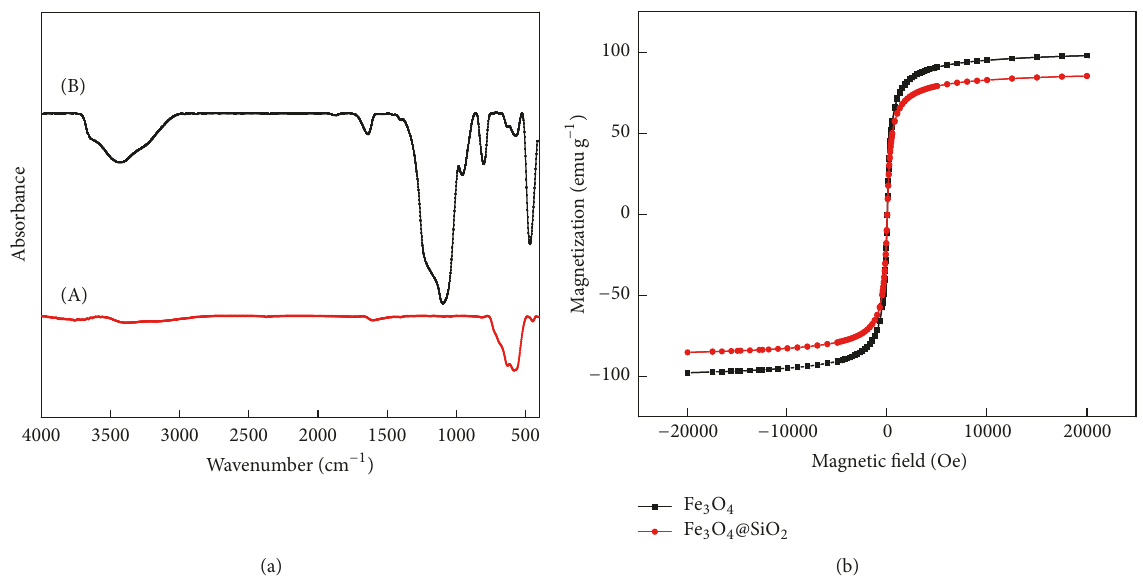
Figure 2: FT-IR spectra and magnetic hysteresis loops: (a) FT-IR spectra of Fe 3 O 4 (A) and Fe 3 O 4 @SiO 2 (B) and (b) magnetic hysteresis loops of Fe 3 O 4 and Fe 3 O 4 @SiO 2